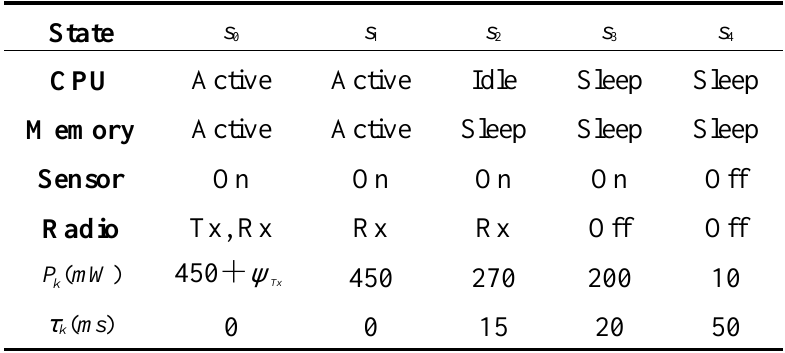
Table 1. Hardware configuration, power consumption and latency threshold of each sleep